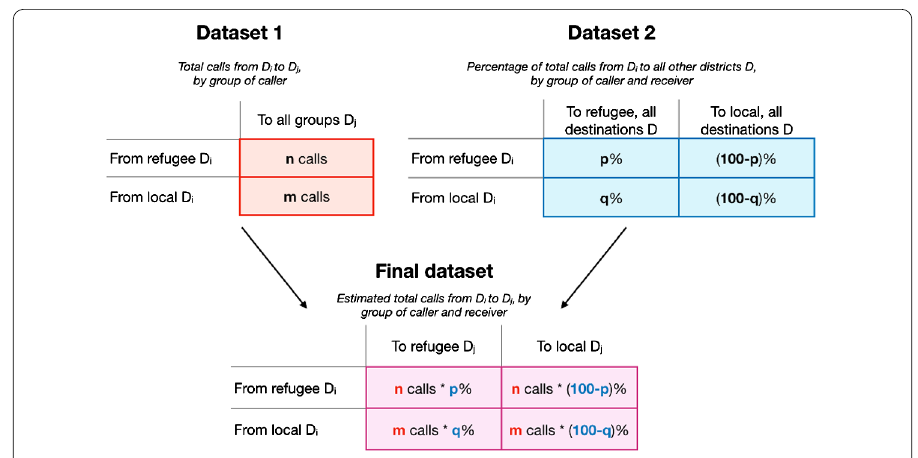
Figure 2 Illustration of the process to merge the information of DS1 and DS2. Top tables indicate the information contained in each individual dataset and bottom table the combined dataset. Colours of entries indicate the dataset from which the information is